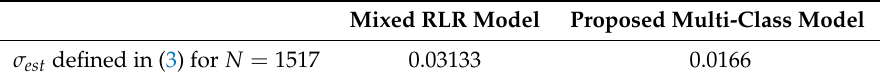
Table 5. Comparison of residual between mixed RLR model and proposed